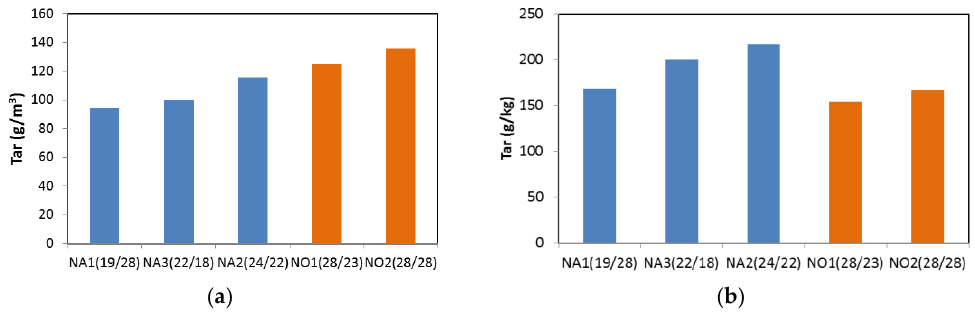
Figure 9. Organic volatiles at the exit of the updraft reactor in the gasification of almond shells (M) and hazelnut shells (N) with air (blue bars) and oxygen (orange bars); ( a ) Gravimetric tar contents per unit of conditioned syngas volume (method CEN TS 15439); ( b ) Tar yields referred to the dry feedstock.